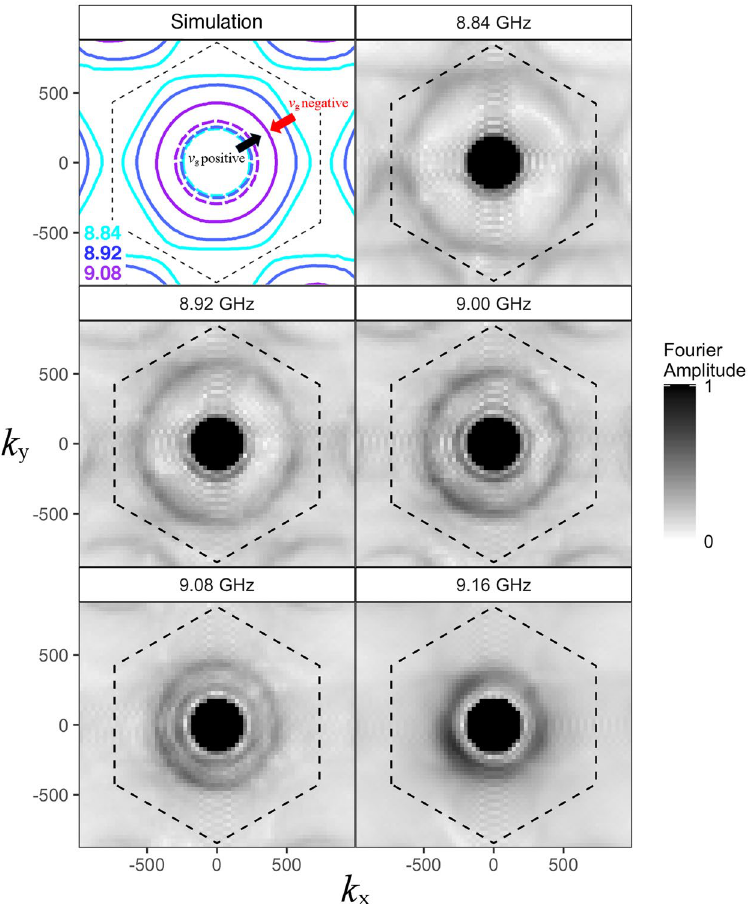
Figure 3. Top left: Simulated (FEM model) isofrequency contours in reciprocal space showing both the positive (forward wave, dashed lines) and negative (backward wave, solid lines) mode index surface waves. Other panels: Fourier amplitude (arbitrary scale) of experimental magnetic-field measured across the plane of the metasurface illustrating the k-dependence of the band as a function of frequency. The light circle is represented by the filled black